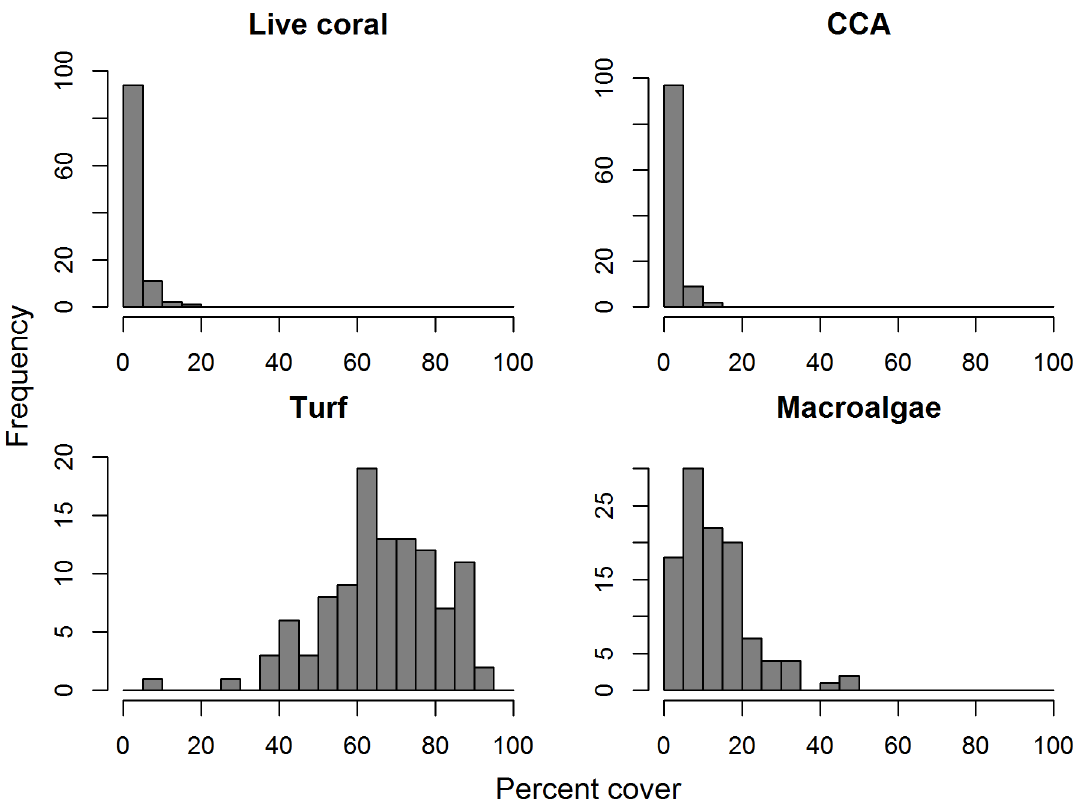
Fig 6. Frequency distribution for percent cover of four major benthic groups. Groups include:Live coral, CCA (crustose corallinealgae), Turf algae,and Macroalgae. Note that y-axis scale changeswith each group.